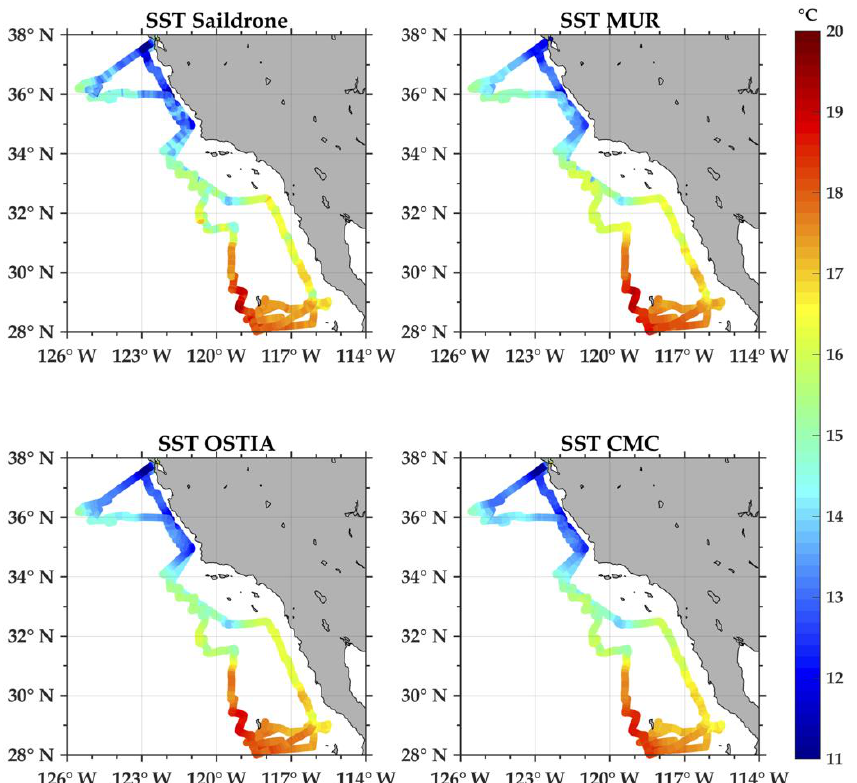
Figure 1. Sea surface temperature (SST) values from a Saildrone CTD, MUR, OSTIA, and the CMC.